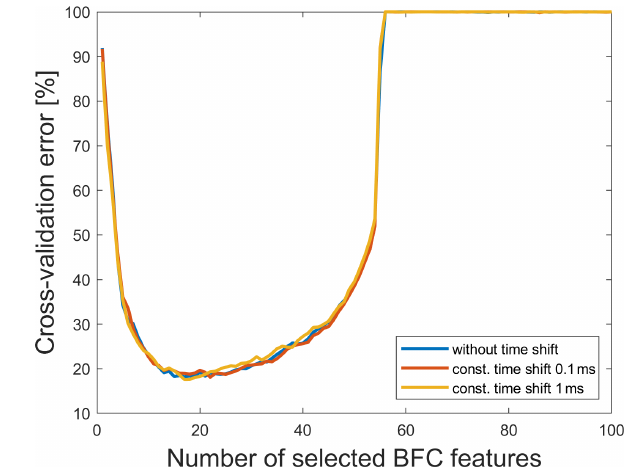
Figure 11. Cross-validation error vs. number of selected features for a maximum time shift of ± 50ms and RFESVM as selector. For a better visibility, only the results with RFESVM as selector are shown.